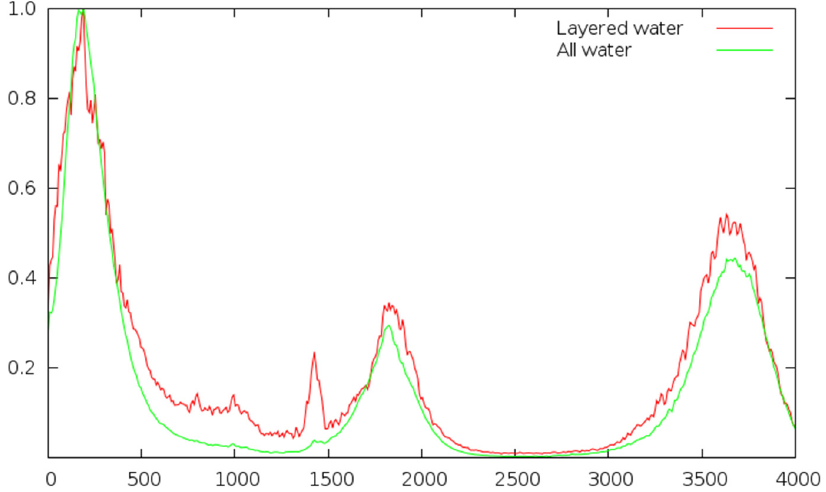
Figure 8. VDOS of hydrogen atoms in the nanoparticle system. The y-axis here is intensity, in arbitrary units.